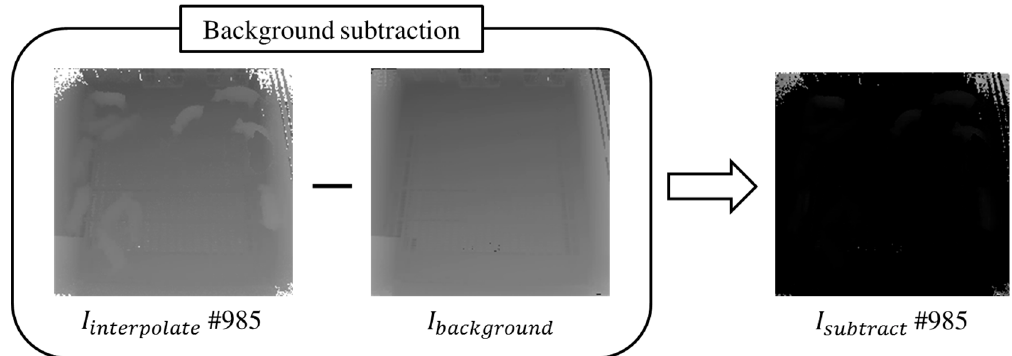
Figure 8. Result of background subtraction.